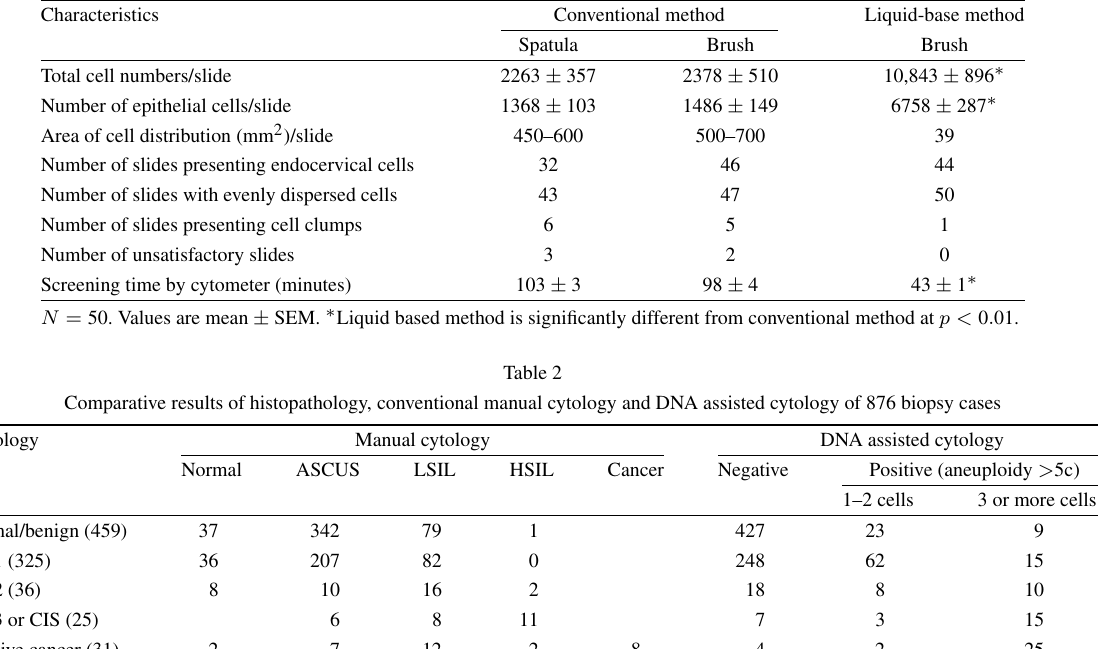
Comparative evaluation of two methods of cell preparation of cervical smears Characteristics